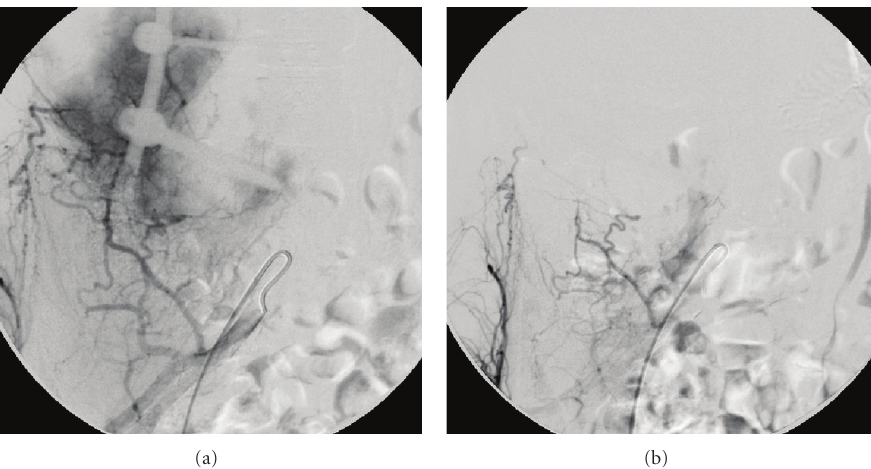
Figure 3: Angiogram before and after selective arterial embolization. (a) Preembolization angiogram of the right internal iliac artery demonstrating a massive hypervascularization of the giant cell tumor (case 6). (b) After embolization with embozene microspheres (250 µ m) a complete devascularization of the giant cell tumor was